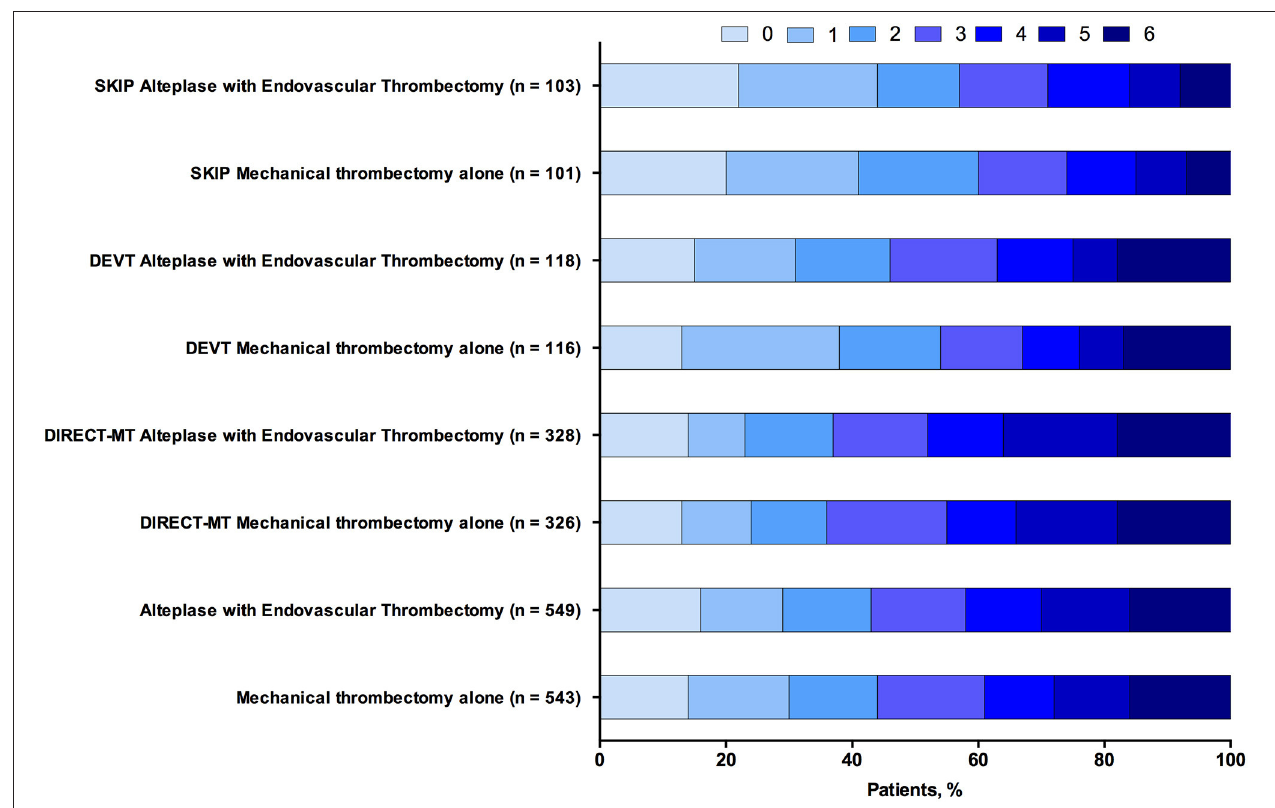
FIGURE 1 | Functional outcome at 90-day follow-up of endovascular thrombectomy alone vs. alteplase with endovascular thrombectomy. The modified Rankin scale measures functional outcome on a seven-point ordinal scale: 0, no symptoms at all; 1, no significant disability despite symptoms; 2, slight disability; 3, moderate disability; 4, moderately severe disability; 5, severe disability; 6, death.